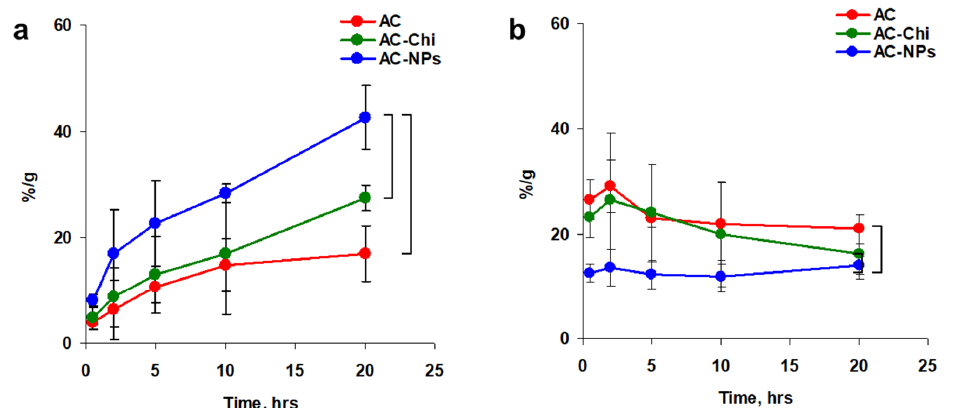
Figure 4. Biodistribution of furano-allocolchicinoid formulations in mice. ( a ) Total MFI collected from organs and blood serum. ( b – d ) AC , AC-Chi , and AC-NPs were IV injected and extracted at 0.5–20 h post injection. Biodistribution of AC ( b ), AC-Chi ( c ), and AC-NPs ( d ) in dynamics. Data are shown as percentages per gram of tissue (%/g).